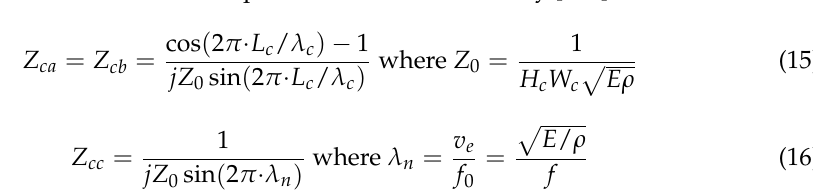
Figure 5. ( a ) Figure of mechanically coupled resonators; ( b ) Dimension of the coupling beam; and ( c ) T-shaped capacitor model for the coupling beam.